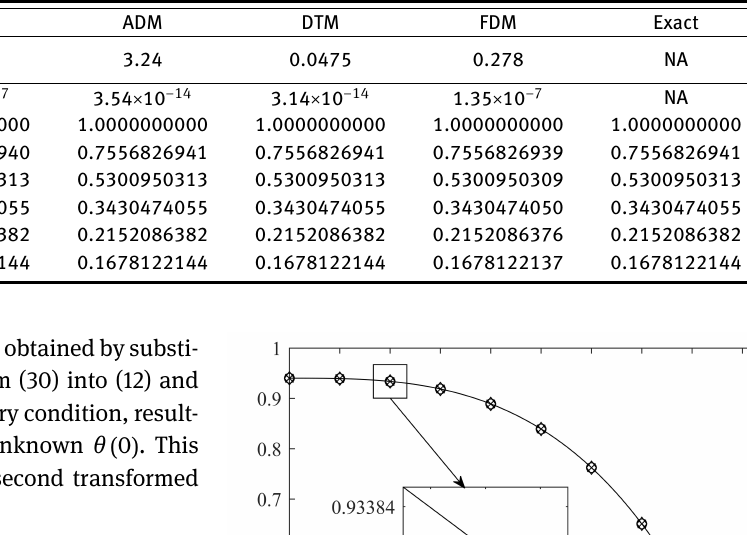
Table 1: Comparison of the required computational time to solve (18) and solutions at six data points